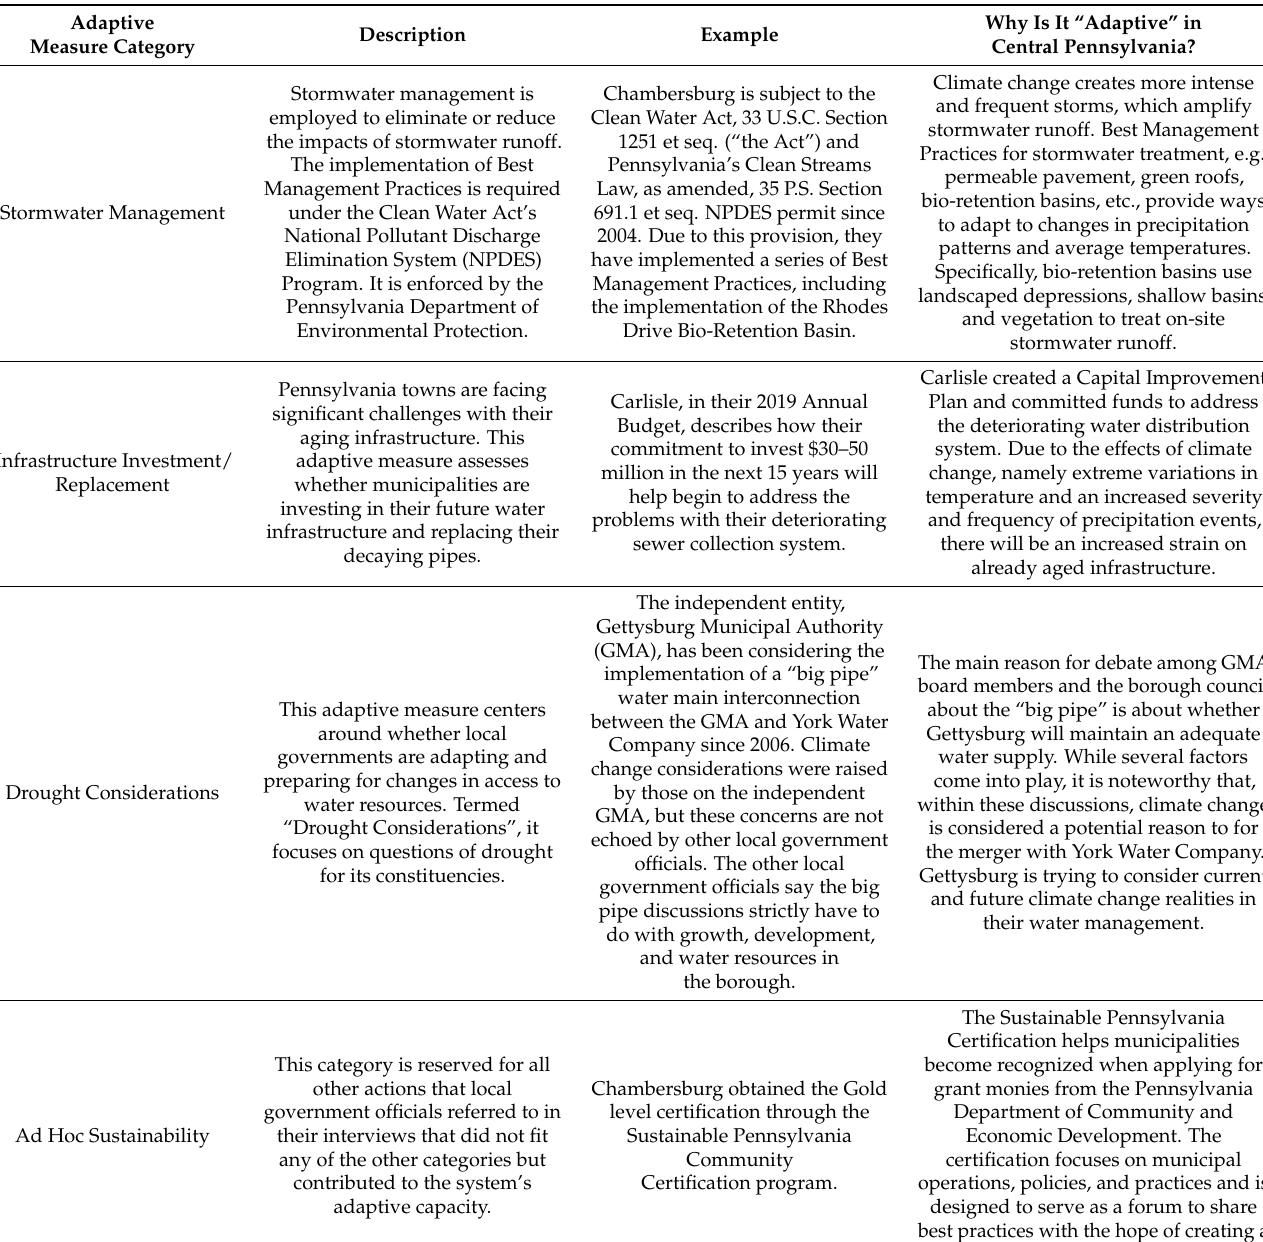
Table 1. Summary Explanation of Adaptive Measure Categories